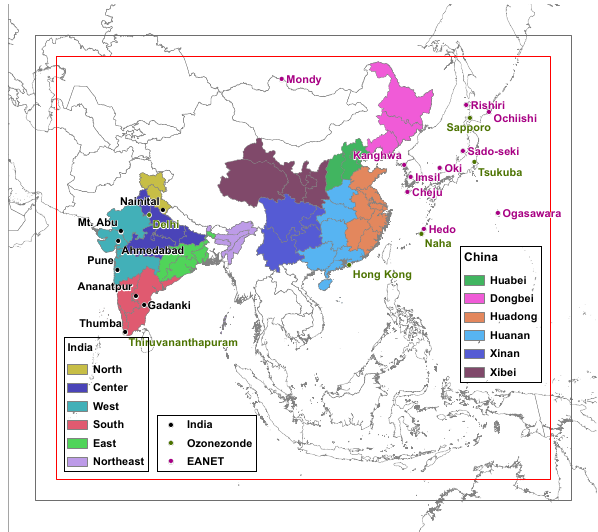
Figure 1. Target domains of WRF-ARW (gray) and CMAQ (red). Monitoring sites of Acid Deposition Monitoring Network in East Asia (EANET), ozonesonde, and India are indicated. Regions in China and India are